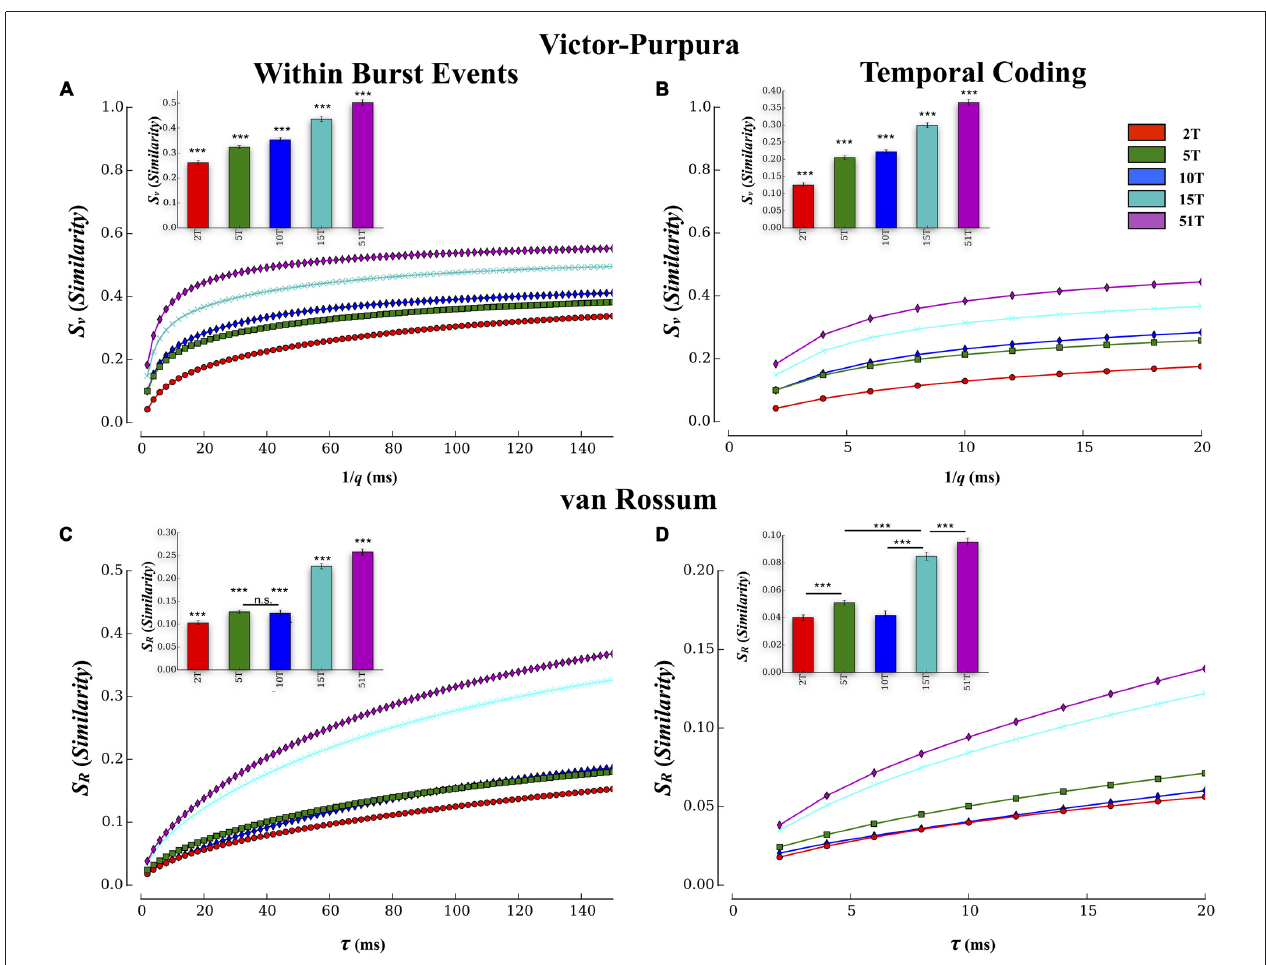
FIGURE 5 | Estimates of transmission fidelity based on the Victor-Purpura and Van Rossum’s metric . Similarity estimates among spike trains provided by the Victor-Purpura and van Rossum’s metric were averaged over electrode pairs for each MEA culture producing a composite score at each level of the metric’s timescale parameter value (1/ q and τ R ). Associated group means are shown as bar plots (inset). Increasing the number of tunnels resulted in a greater transmission fidelity between layers based on similarity estimates using Victor’s (A,B) and van Rossum’s metric (C,D) . Increased fidelity was apparent at both rate (1/ q > 80 ms and τ R > 80 ms) and temporal scales (1/ q < 20 ms and τ R < 20 ms) of each measure. These estimates were conducted during periods in which bursting was actively propagating and temporally overlapped from Layer I and II. Similar results were also observed if we computed these metrics to include the entire duration